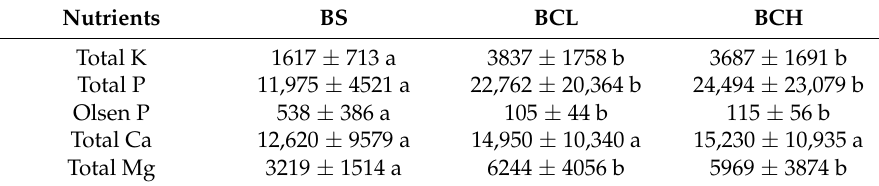
Table 4. Nutrient contents (mg/kg) of the biosolids and corresponding biochar samples. BS: biosolids, BCL: biochars prepared at low temperature, BCH: biochars prepared at high temperature. Different letters within the same row represent significant differences in the mean values.